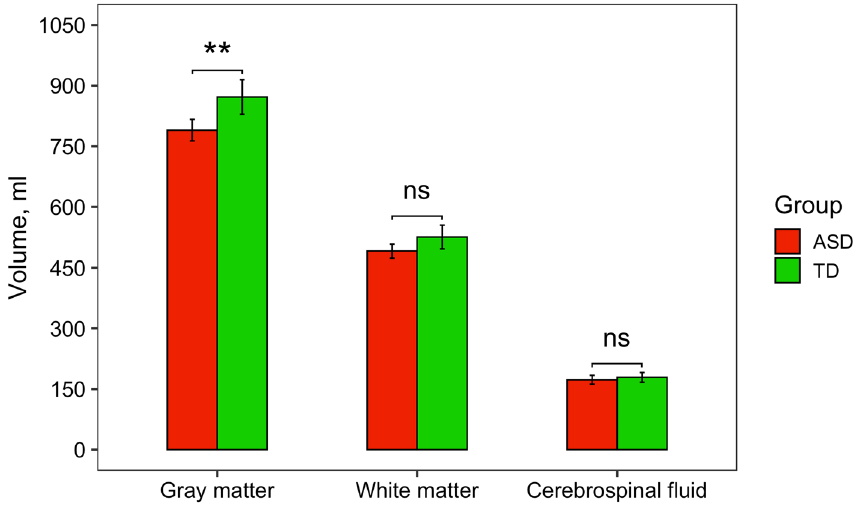
Figure 2. The comparison of total brain GM, WM, and CSF volumes (ml) between ASD and TD groups of children (significant effects are indicated with * p < 0.05, ** p < 0.01, ns non-significant; all p -values are